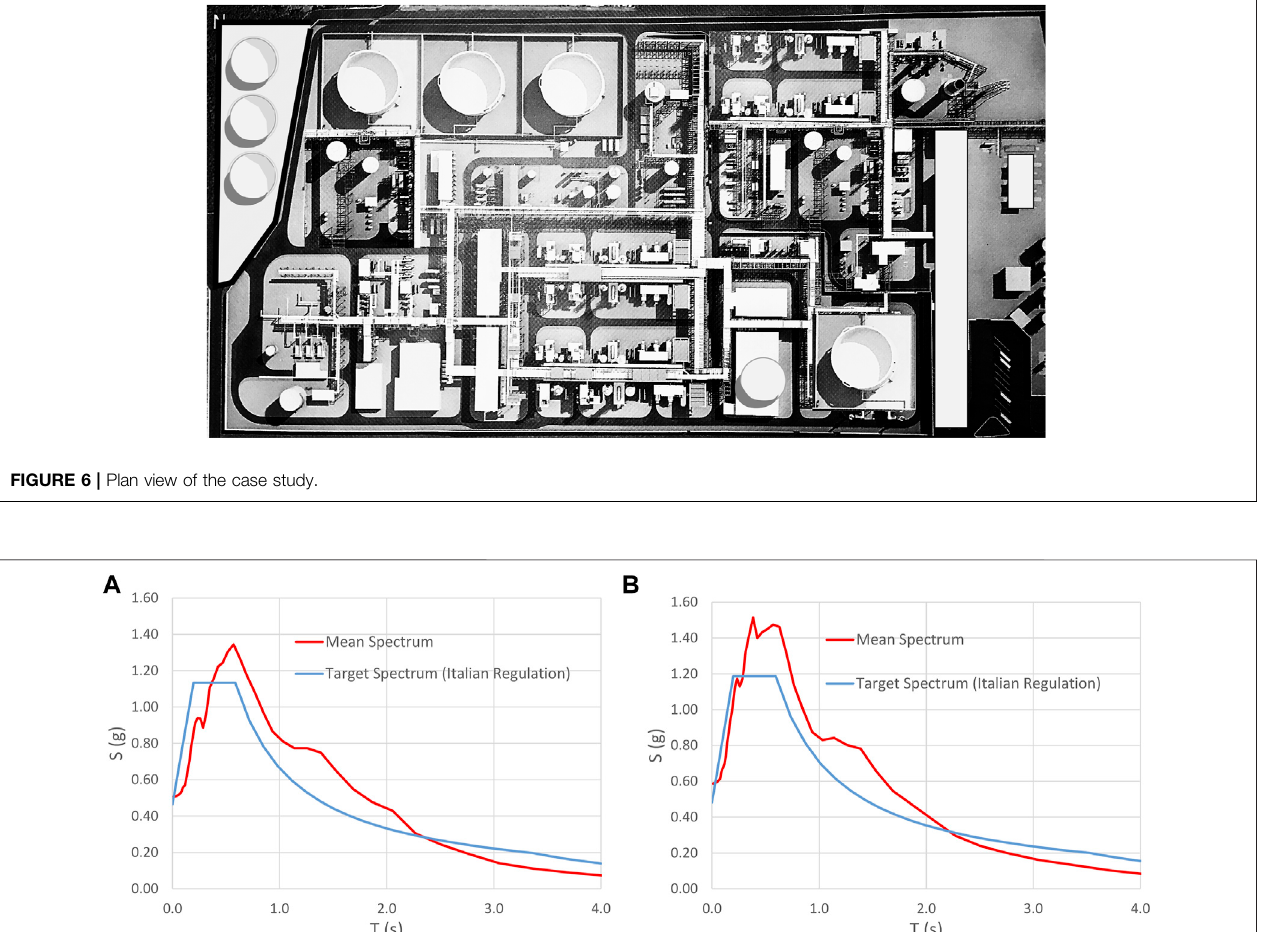
Frontiers in Built Environment |